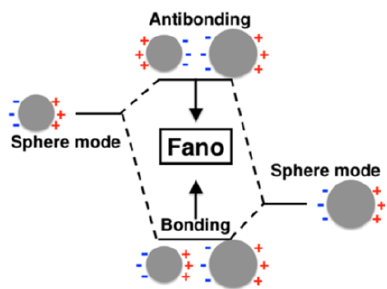
Figure 3. The schematic diagram of the plasmon hybridization in the cascaded graphene-coated dimer. The Fano resonance arises due to the interference between antibonding and bonding